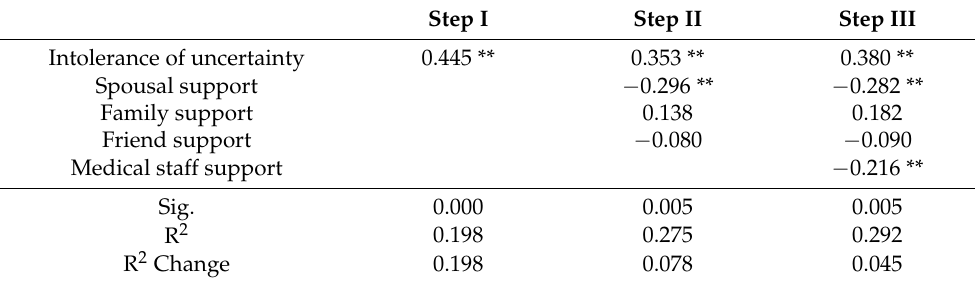
Table 2. Hierarchical regression coefficients for predicting maternal psychological distress by intoler- ance of uncertainty and formal and informal